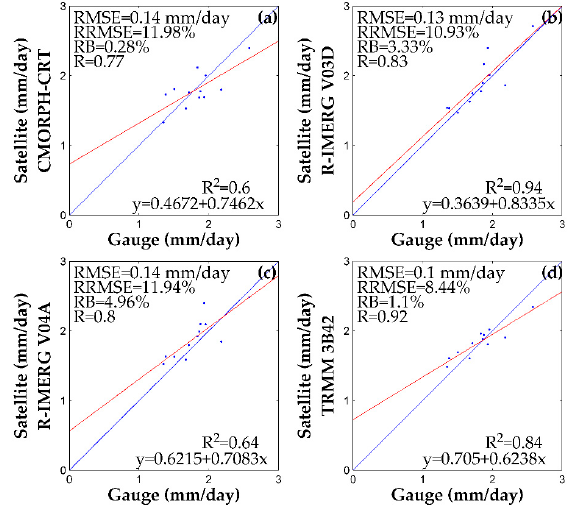
Figure 12. Scatterplots of the four satellite-based estimates versus rain gauge observations of average daily rainfall for CMORPH-CRT ( a ); R-IMERG V03D ( b ); R-IMERG V04A ( c ); and TRMM 3B42 ( d ) over the Weihe River Basin between June 2014 and November 2015. The blue and red oblique solid lines denote a 1:1 line and a least-squares regression line, respectively.